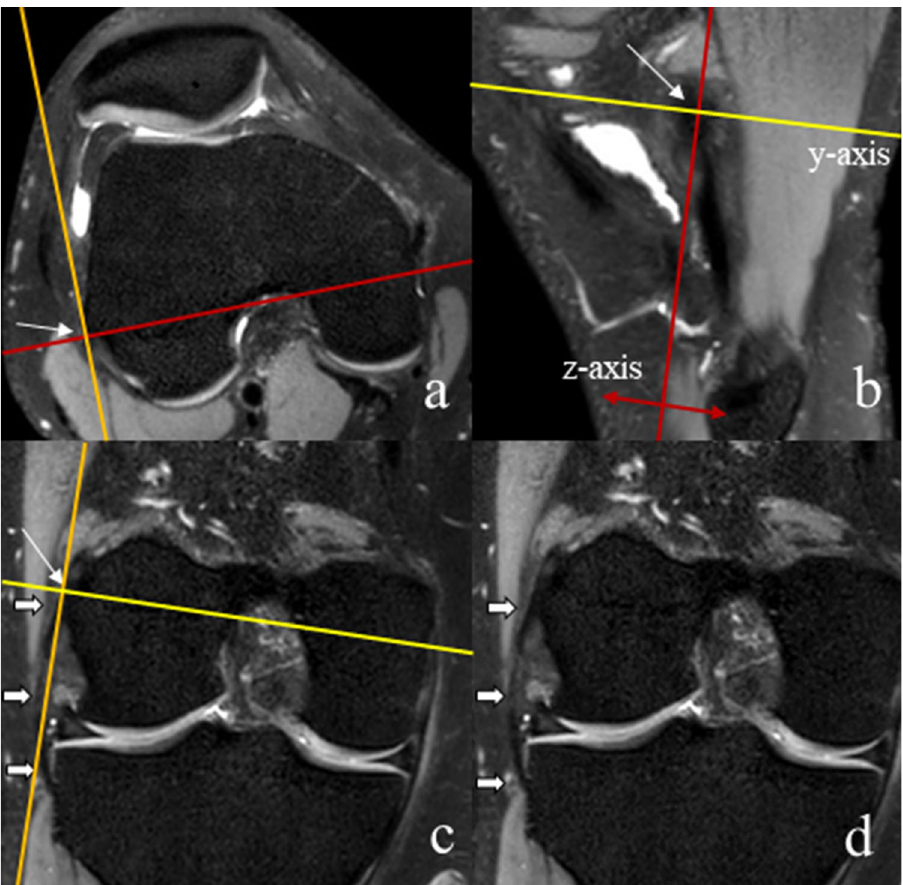
Figure 4. Visualization of the anterolateral ligament (ALL), using multiplanar reformation (MPR) with all planes visible and connected to each other, by tilting the coronal plane in the sagittal image ( b ; z-axis) with the center of rotation at the lateral epicondyle (origin of MPR coordinate system; a – c ; white arrow). This results in full visibility of the ALL in the coronal image ( c , d ; white bold arrows). The red arrows indicate the possible directions of tilting the coronal plane around the center of rotation.